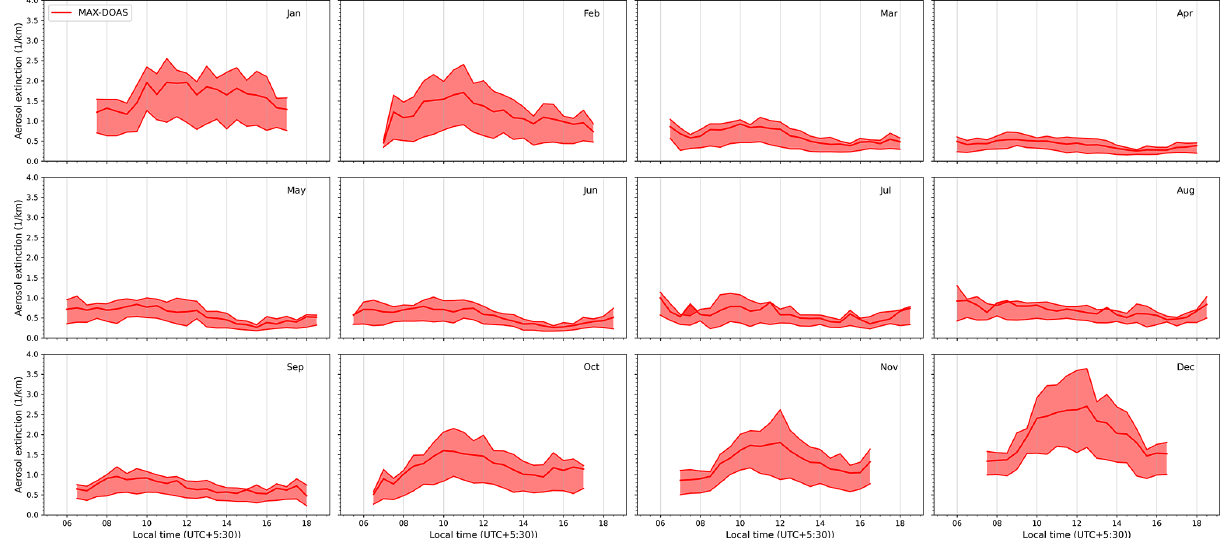
Figure F9. Mean diurnal profiles of the aerosol extinction in the bottom-most layer (0–200m) retrieved from the MAX-DOAS measurements for different months of the year. The dark line represents the mean value, while the shaded region above and below the dark lines represent the 75th and 25th percentiles, respectively.